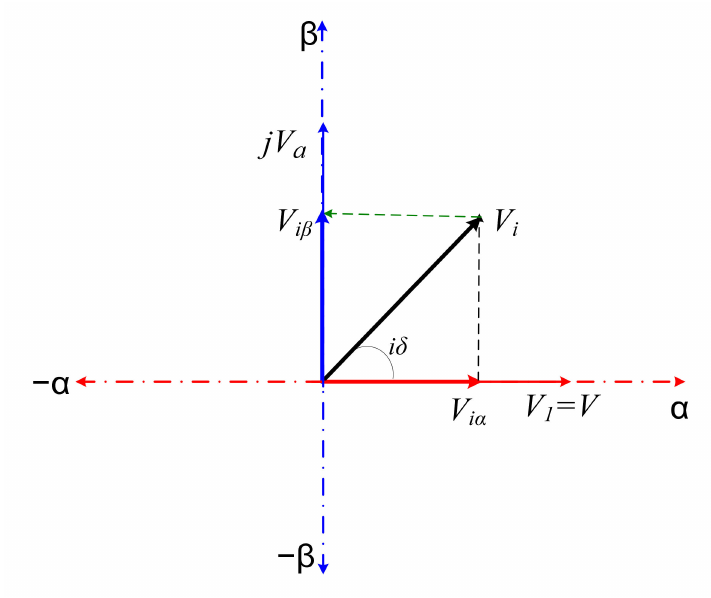
Figure 2. Representation of a phasor diagram for two-phase to n -phase